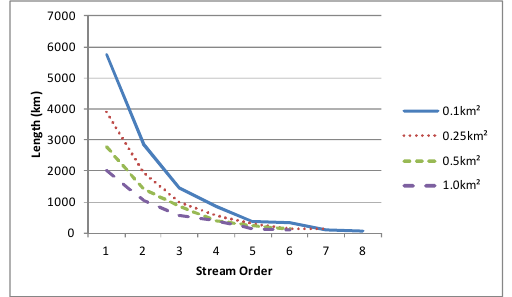
Figure 8. Stream Ordered Waterways 20m DEM (various catchment input areas) Figure 9, Sample Stream Order Maps, Various Input Value displays waterways generated at different catchment input parameters.